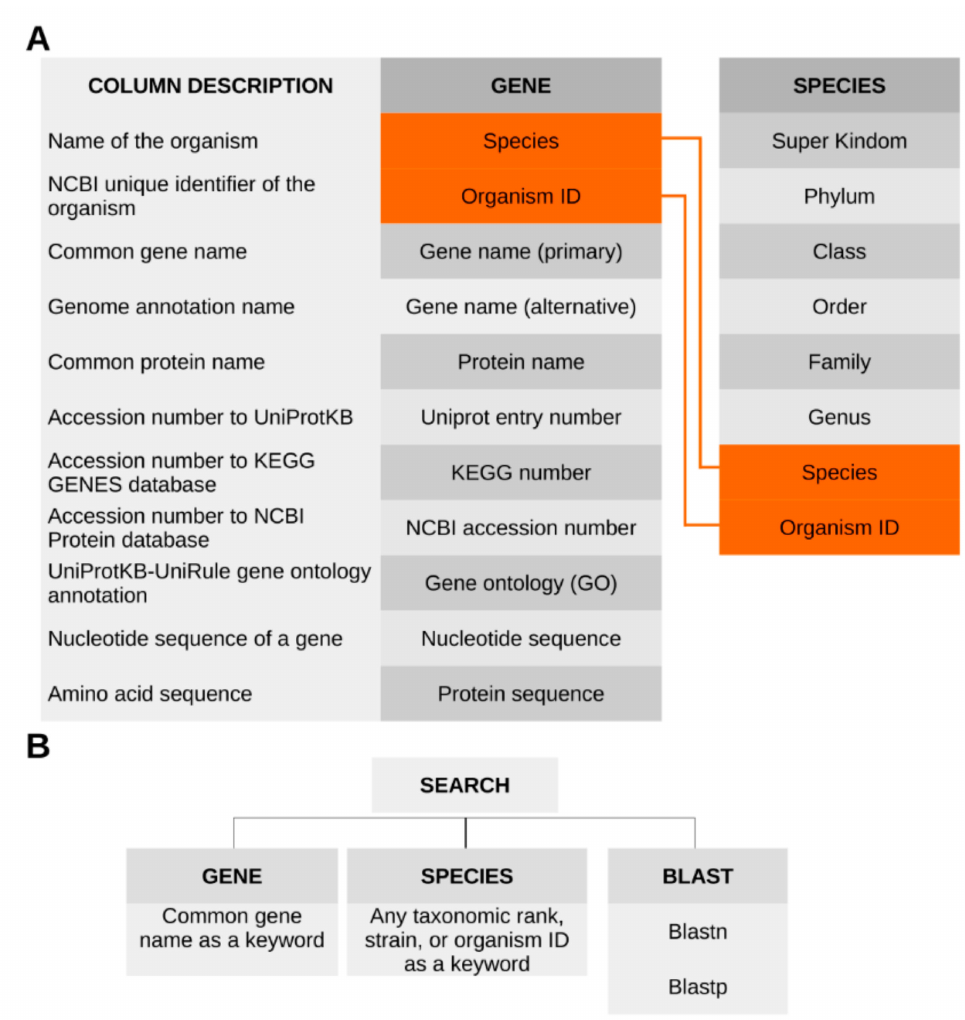
Figure 2. Structure and search tools of the DetR DB. ( A ) Structure and content of the database. Orange boxes indicate the interlinked columns. The column on the left explains di ff erent attributes of a “GENE” entity. ( B ) There are three options for search: by gene name, by taxonomy, or with BLAST